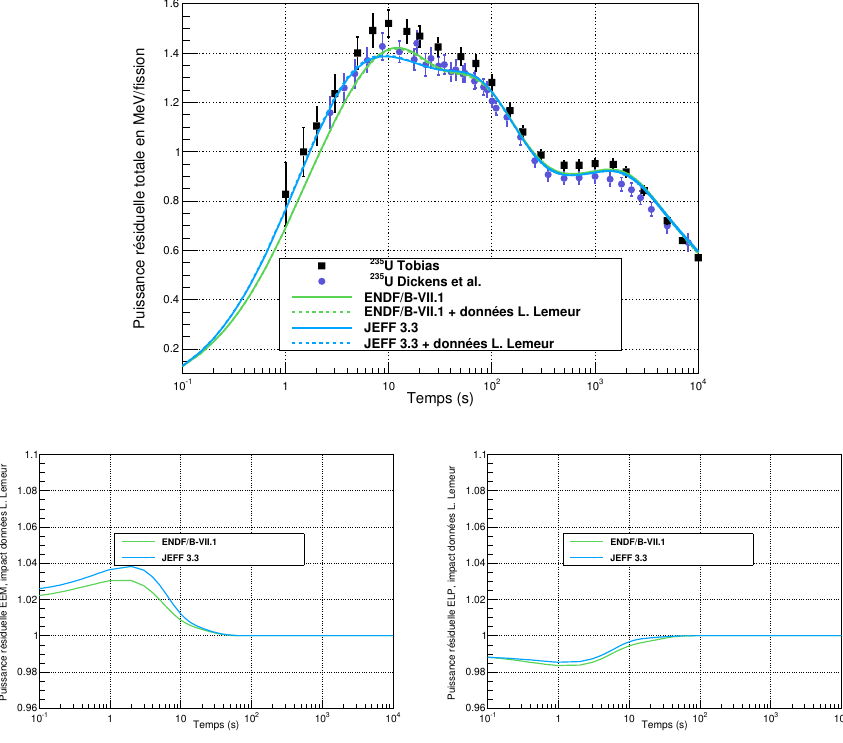
Figure 3. Top: 235 U fission pulse total decay heat computed with ENDF / B-VII (green) and JEFF3.3 (blue) and compared to Tobias et. al and Dickens et al [23]. Bottom: impact of the 3 nuclei 99 Y, 138 I, 142 Cs on the electromagnetic and light particle components of the decay heat respectively, calculated with ENDF / B-VII (green) and JEFF3.3